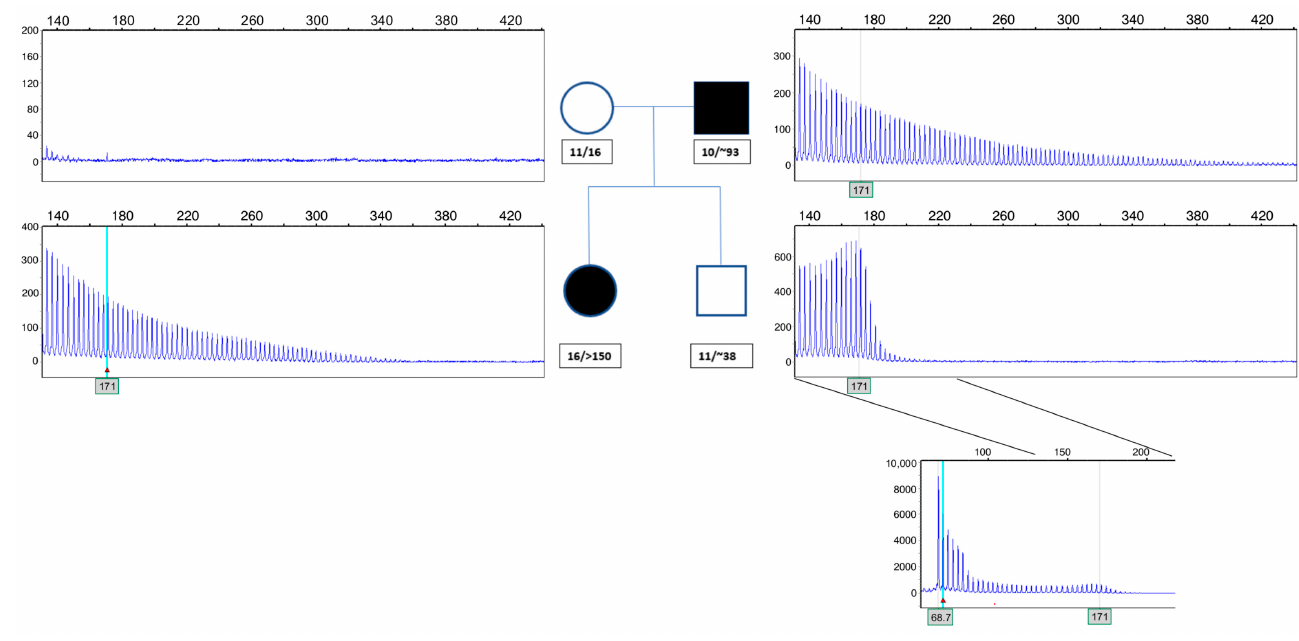
Figure 1. Segregation analysis revealed the contraction of an allele with ~100 repeats to 38 repeats when transmitted from a father to his asymptomatic son (family DM347). Table 2. Premutations, protomutations, and full-sized mutations detected in subjects referred for DM1.